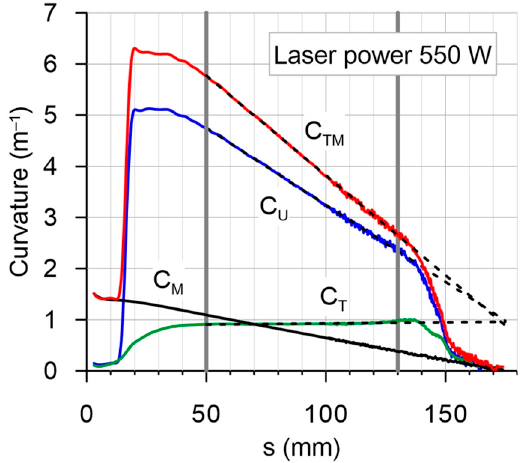
Figure 4. Calculated beam curvature as a function of the beam parameter s .